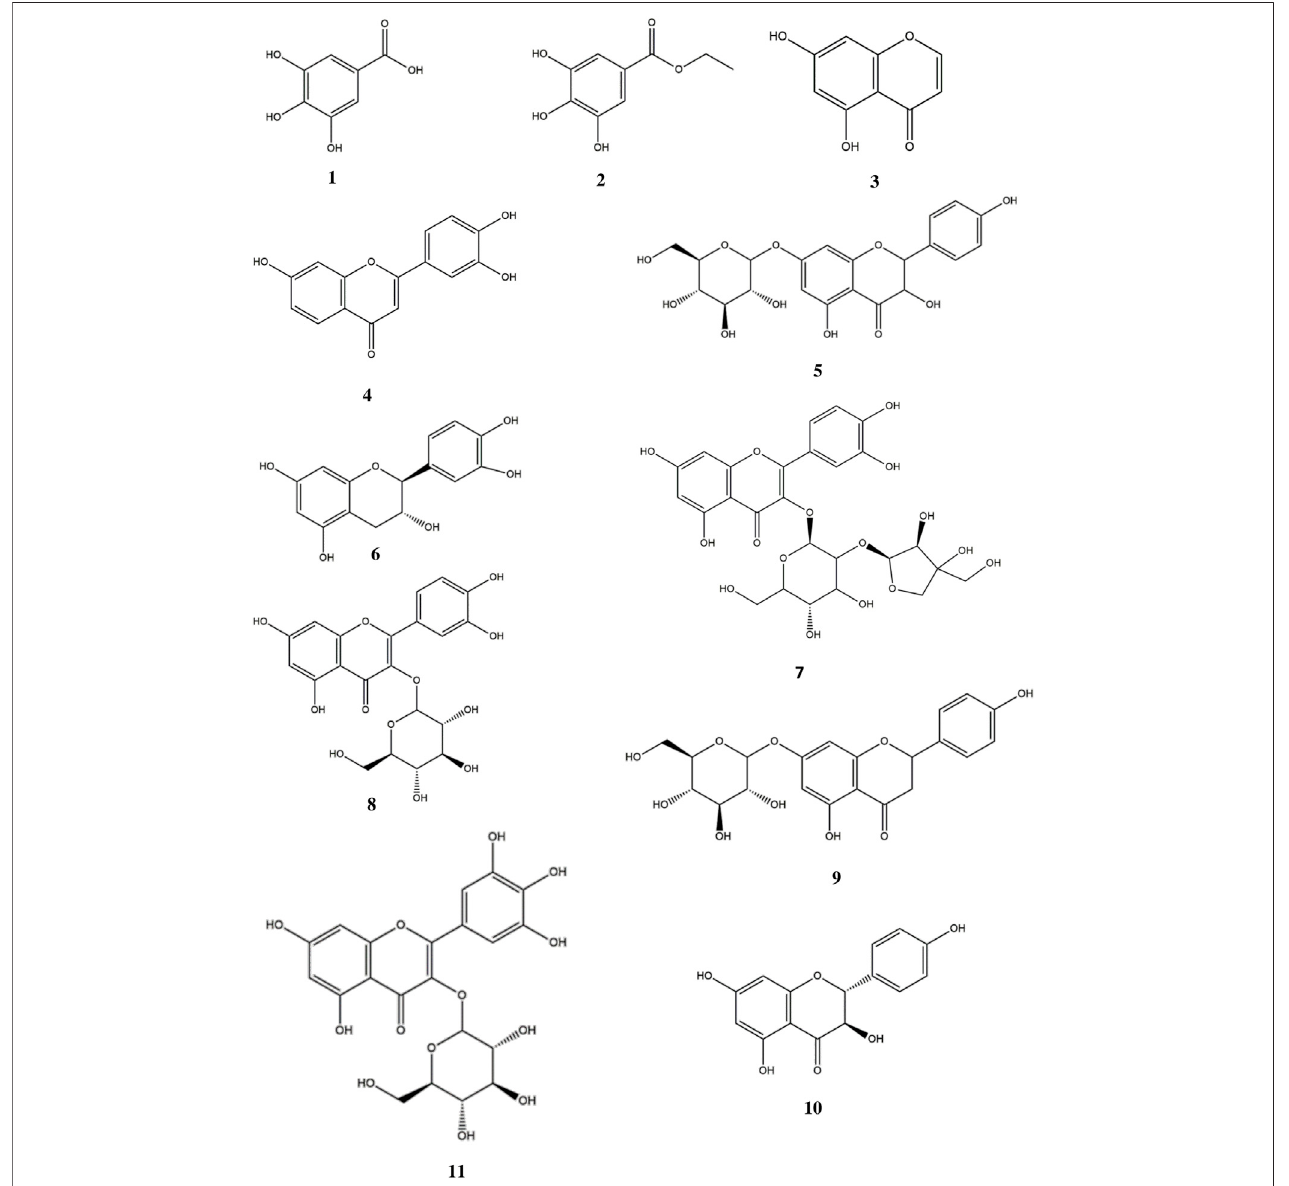
FIGURE 2 | Phenolic compounds isolated from Entada africana : Gallic acid (1) , Ethyl gallate ( 2 ), 5,7-dihydroxychromone ( 3 ) and 3 ′ ,4 ′ ,7-trihydroxy fl avone (4) from fraction FC3. Dihydrokaempferol-7- O - glucopyranoside ( 5 ) and catechin ( 6 ) from FC4-II, FC4-III yielded quercetin-3- O -[ β -apiosyl-(1 ″ → 2 ″ )- β -glucopyranoside] ( 7 ), isoquercitrin ( 8 ), prunin ( 9 ) and aromadendrin [syn. dihydrokaempferol ( 10 )]. Myricetin-3- O -glucopyranoside ( 11 ) obtained from FC8.